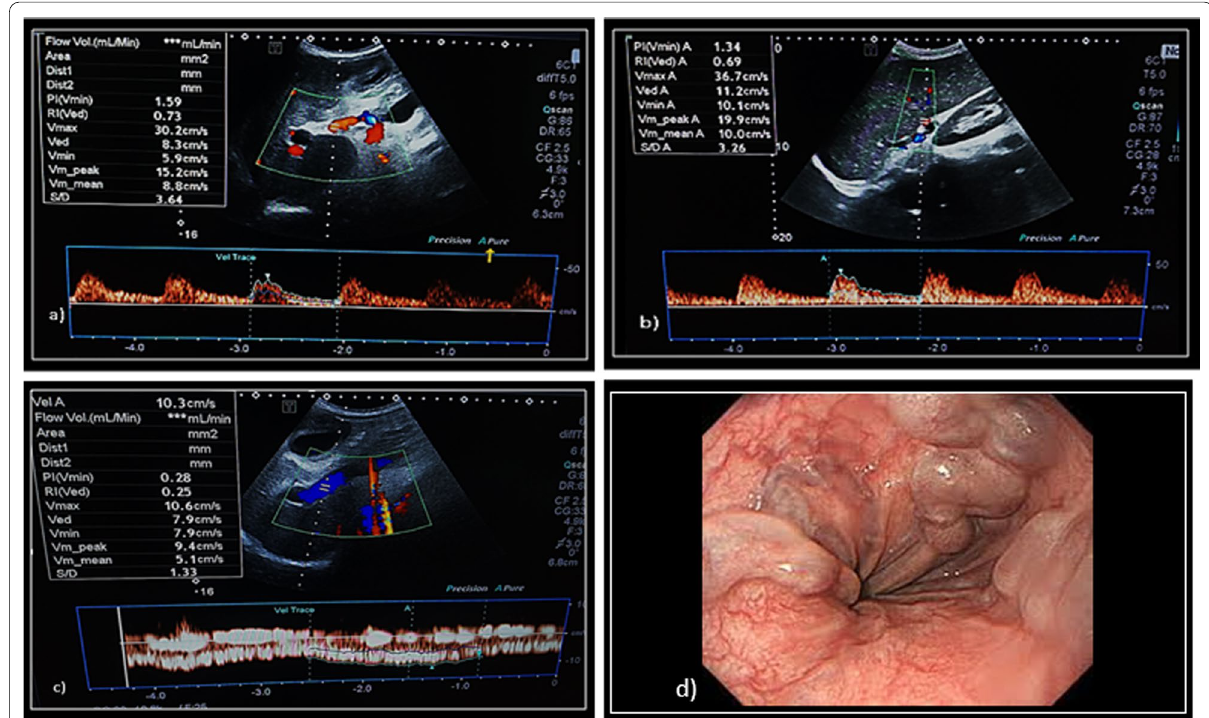
Fig. 1 67 Y male patient with chronic liver disease, a presents Doppler U/S of hepatic artery with HAPI: 2.60 and HARI: 0.84. b Presents Doppler U/S of splenic artery with SARI: 0.82, the splenic bipolar diameter is 15.3 cm. c PResents Doppler U/S of PV with MVPV: 9.4 cm/s. PV diameter is 15.0 mm. d UGIE revealed grade IV oesophageal